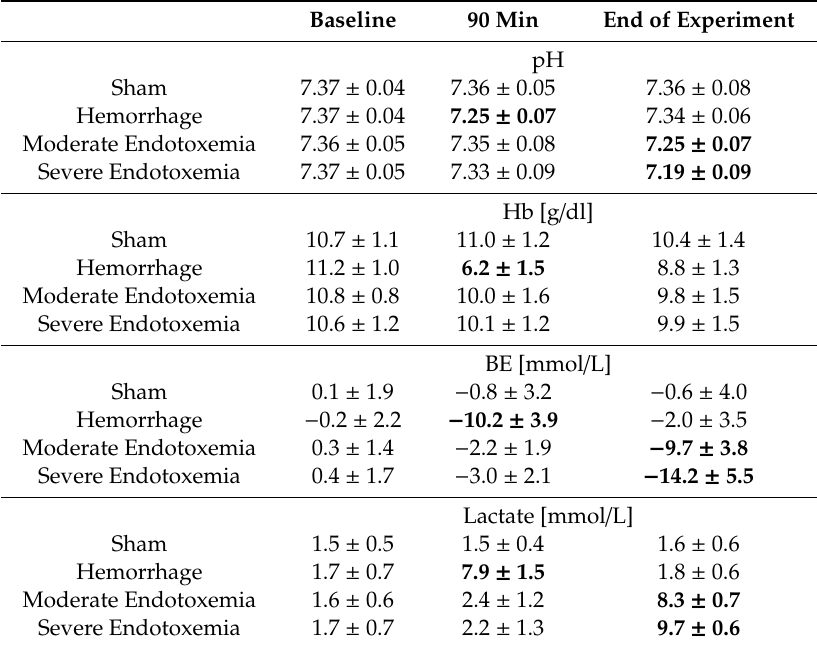
Table 1. Blood-gas-analysis.